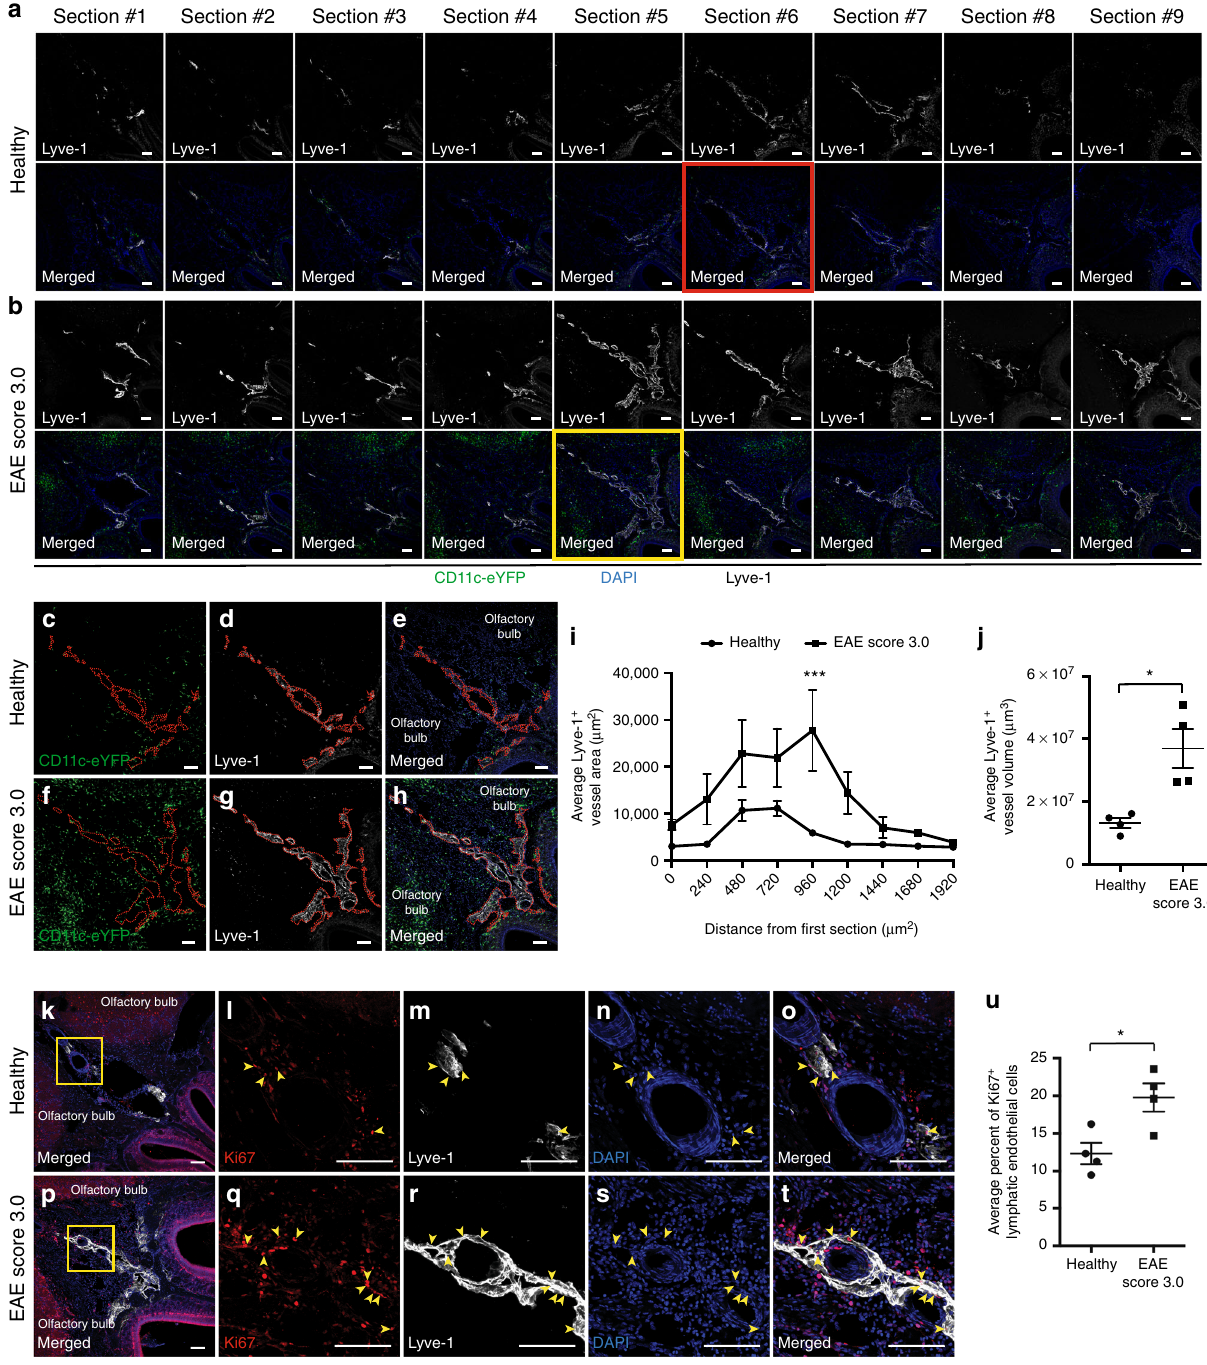
Fig. 2 EAE induces lymphangiogenesis near the cribriform plate. a , b Nine representative serial coronal sections of the lymphatic vessels near the cribriform plate were imaged from either a healthy ( a ) or an EAE Score 3.0 collected 18 days post-immunization ( b ) CD11c-eYFP transgenic reporter mouse were immunolabeled with Lyve-1 and DAPI. Note the increase in Lyve-1 + vessel area during EAE versus healthy mice. Scale bars = 100 μ m. c – h Enlarged images of the red inset in a or yellow inset in b showing the section with the largest Lyve-1 + vessel area in healthy ( c – e ) versus EAE Score 3.0 ( f – h ) out of nine serial coronal sections. Scale bars = 100 μ m. i , j Quantitation of the average Lyve-1 + vessel area across nine serial sections ( i ) ( n = 4 mice per group; data are represented as mean ± SEM, *** p < 0.001, repeated two-way ANOVA using Sidaks multiple comparison test) or the average Lyve-1 + vessel volume ( j ) ( n = 4 mice per group; data are represented as mean ± SEM, * p < 0.05, unpaired Student ’ s t -test). k – t Proliferation of lymphatic endothelial cells measured by Ki67 + nuclei within healthy ( k – o ) or EAE Score 3.0 mice ( p – t ). Ki67 + Lyve-1 + lymphatic endothelial cells were quanti fi ed using orthogonal views to con fi rm that the cells used for quantitation were in fact proliferating lymphatic endothelial cells. Yellow arrowheads indicate Ki67 + nuclei within Lyve-1 + vessels. Scale bars, 100 μ m in a – t . Scale bars = 100 μ m. u Quantitation of the average percent of Ki67 + nuclei within Lyve-1 + vessels between healthy and EAE Score 3.0 mice ( n = 4 mice per group; data are represented as mean ± SEM, * p < 0.05, unpaired Student ’ s t